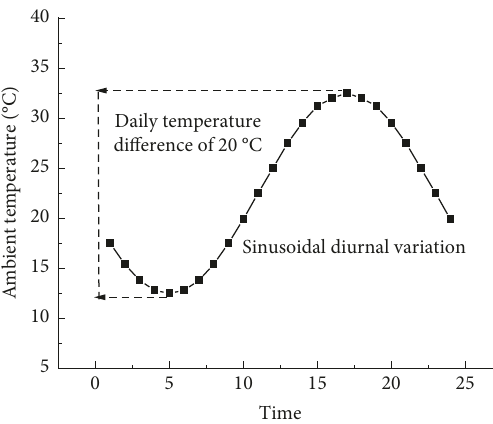
Figure 2: The daily variation of intensity on the Earth ambient temperature.